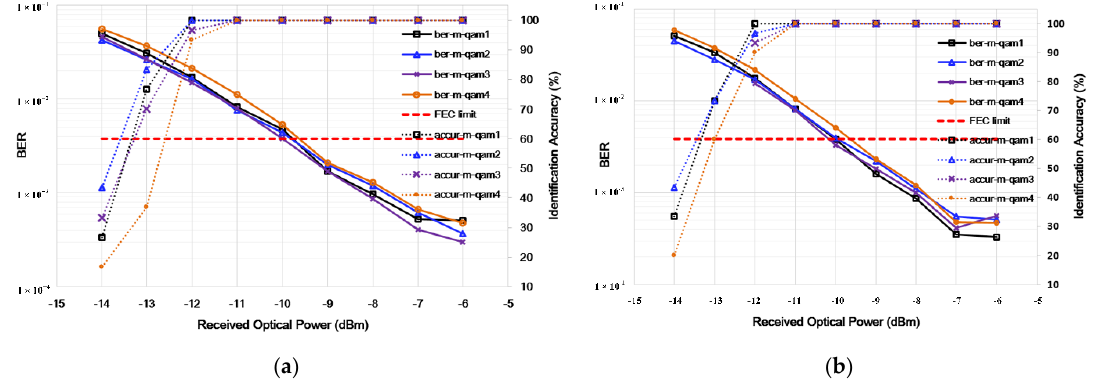
Figure 6. The BER curves and identification accuracy for ( a ) OBTB and ( b ) 25 km SSMF configurations.